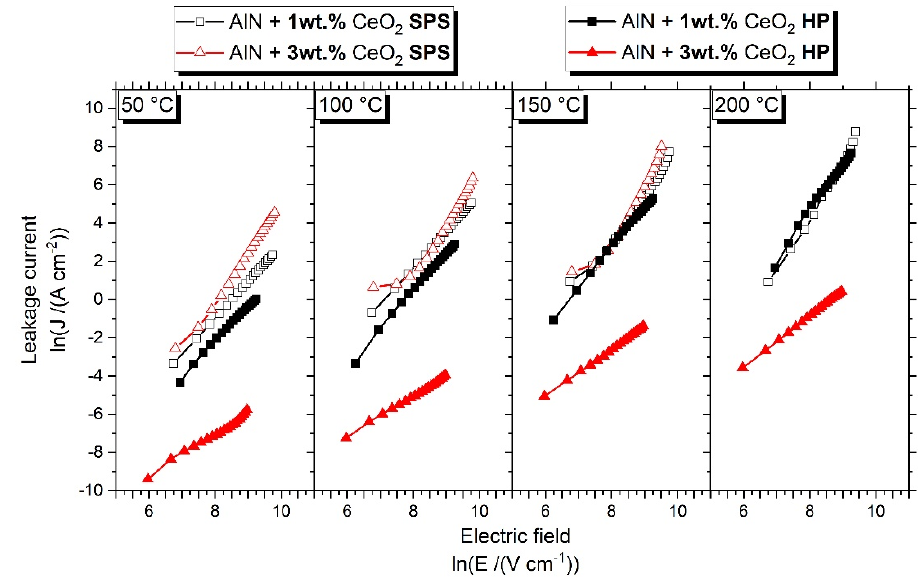
Figure 14. Leakage current measurement of HP and SPS samples.